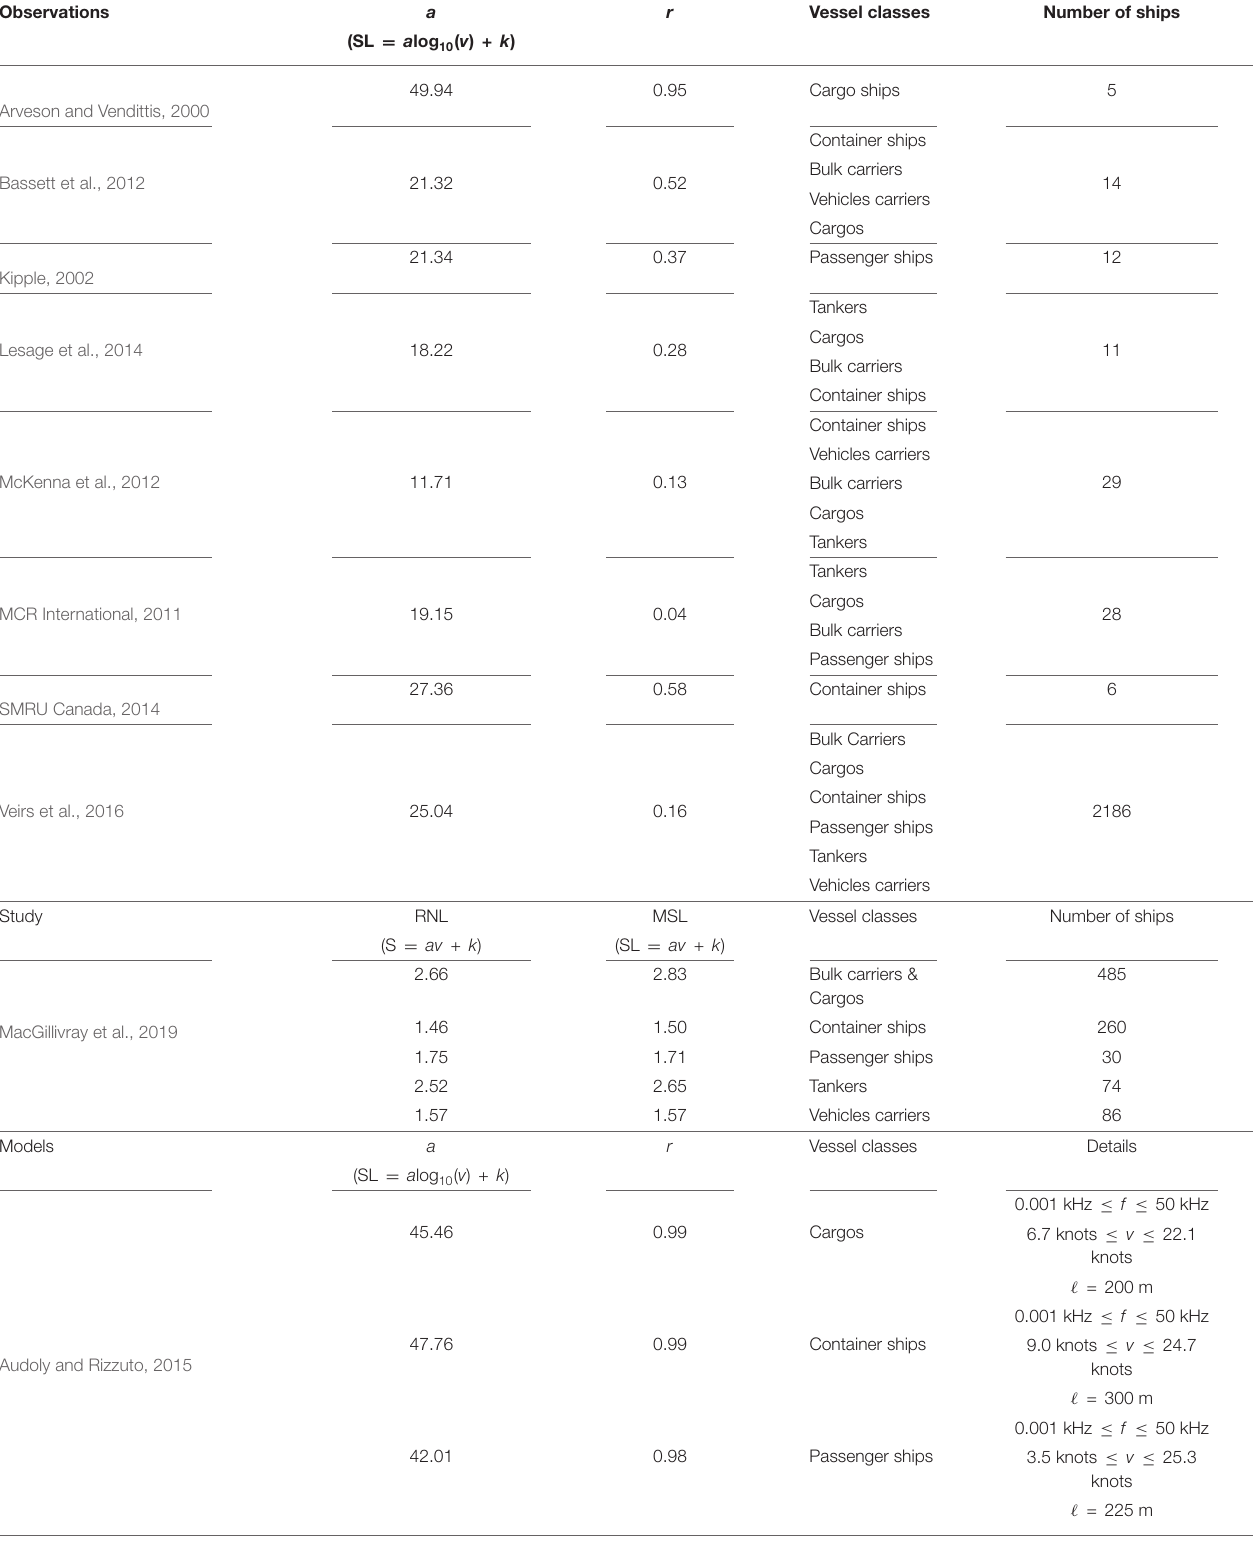
TABLE 4 | Source levels vs. ships’ Speed Relation. Upper panel: Observational studies listed in Tables 1, 2